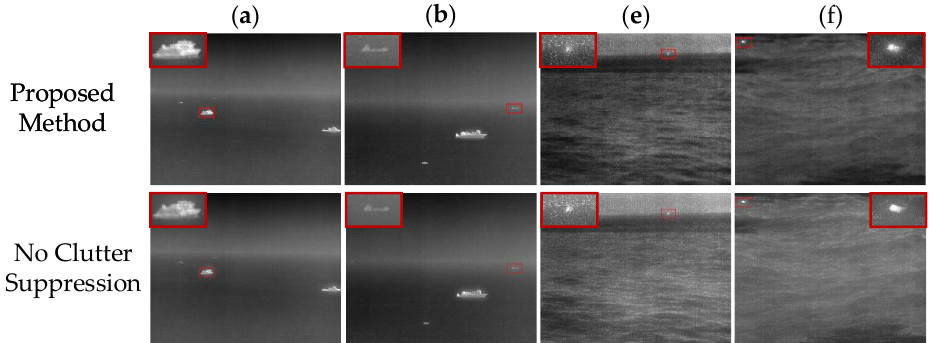
Figure 14. Comparative results of ablation study. The proposed method represents the result image of the complete method proposed in this paper. No clutter suppression indicates the result of no clutter suppression operation. ( a , b , e , f ) correspond to the processing results of the original infrared image in Figure 13, respectively.